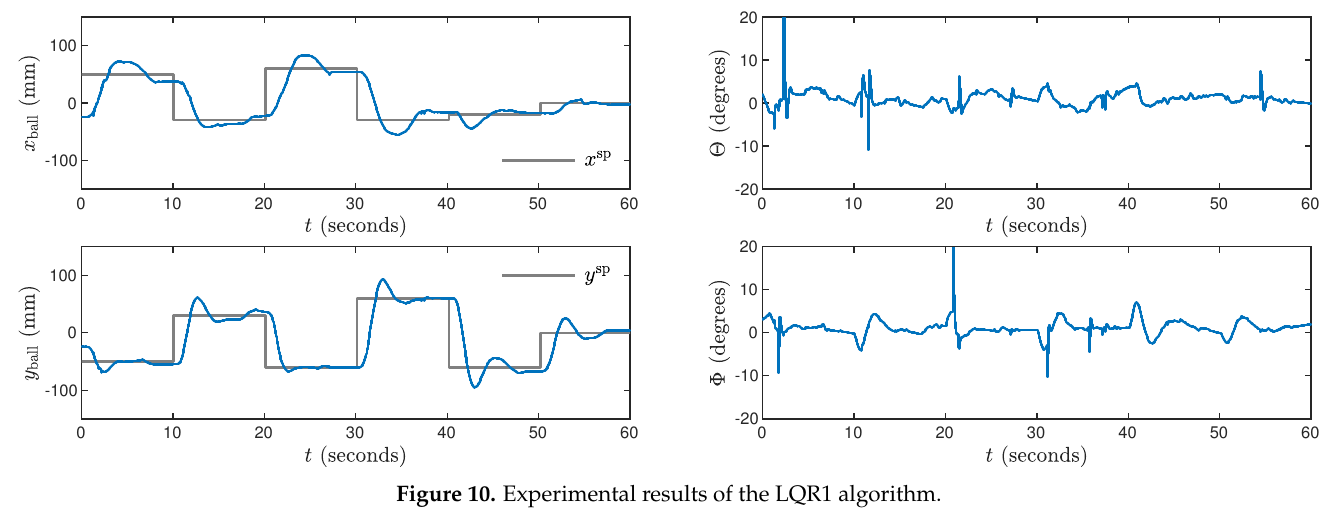
Figure 10. Experimental results of the LQR1 algorithm.